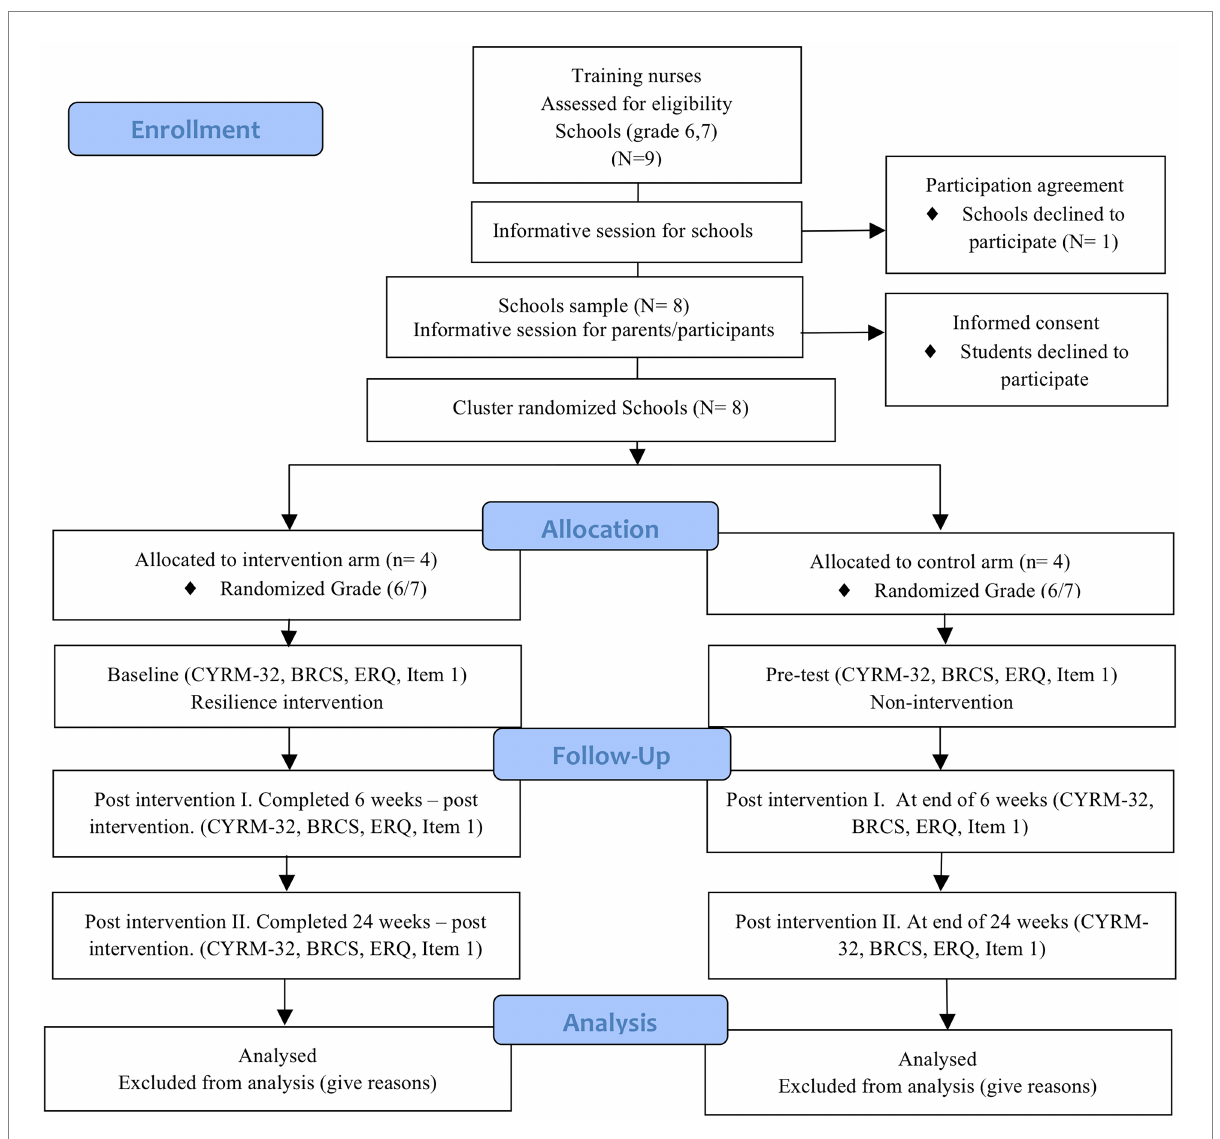
FIGURE 2 Consolidated standards of reporting clinical trial (CONSORT) flow chart, explaining the study settings, and how and when data will be collected. N , number of schools that have been involved in the specified step. CYRM-32, child youth resilience measure-32; BRCS, brief resilience scale; Item 1, “Are You Depressed or